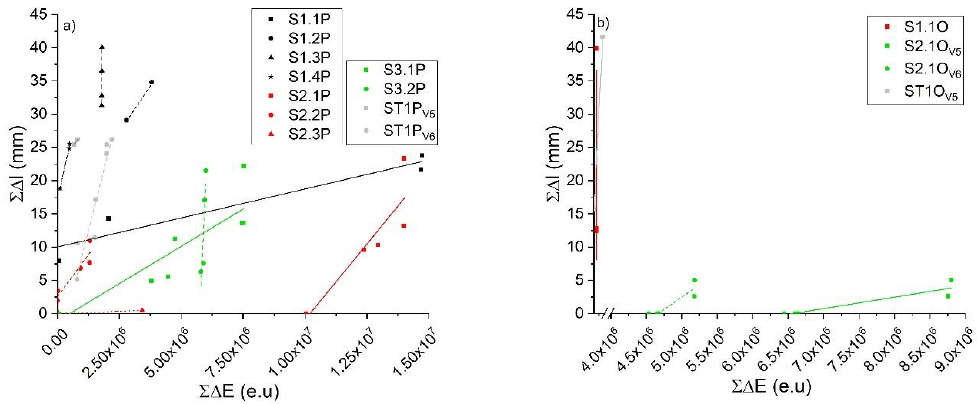
Figure 8. Experimental values and fracture mechanism calibration curves obtained for the brittle-like states (BL) of specimens listed in Tables 1 and 4. ( a ) Pine; ( b ) Oak. Table 3. Dimension of crack lengths as observed by the camera (true crack) and by the AE system (calculated crack). The factor ratio FR (pure number) is representative of the detection quality of the AE in terms of elastic energy released during the brittle fracture.